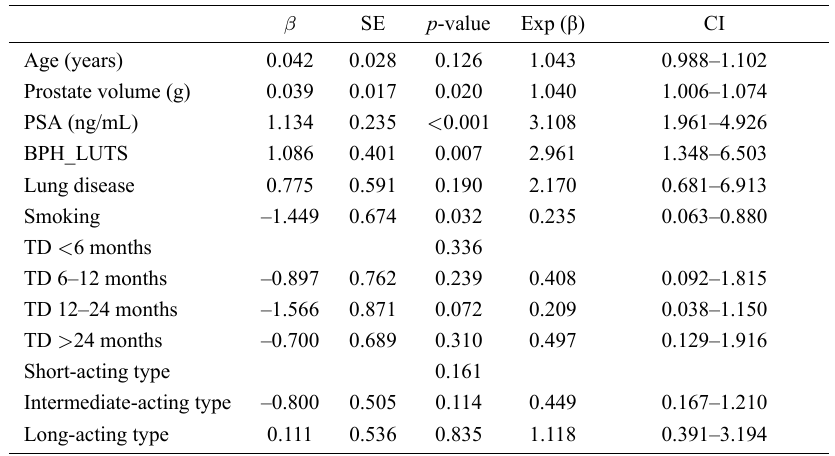
Table 2. Multivariate analysis results based on logistic regression performed for clinical factors associated with PSA elevation occurring during testosterone